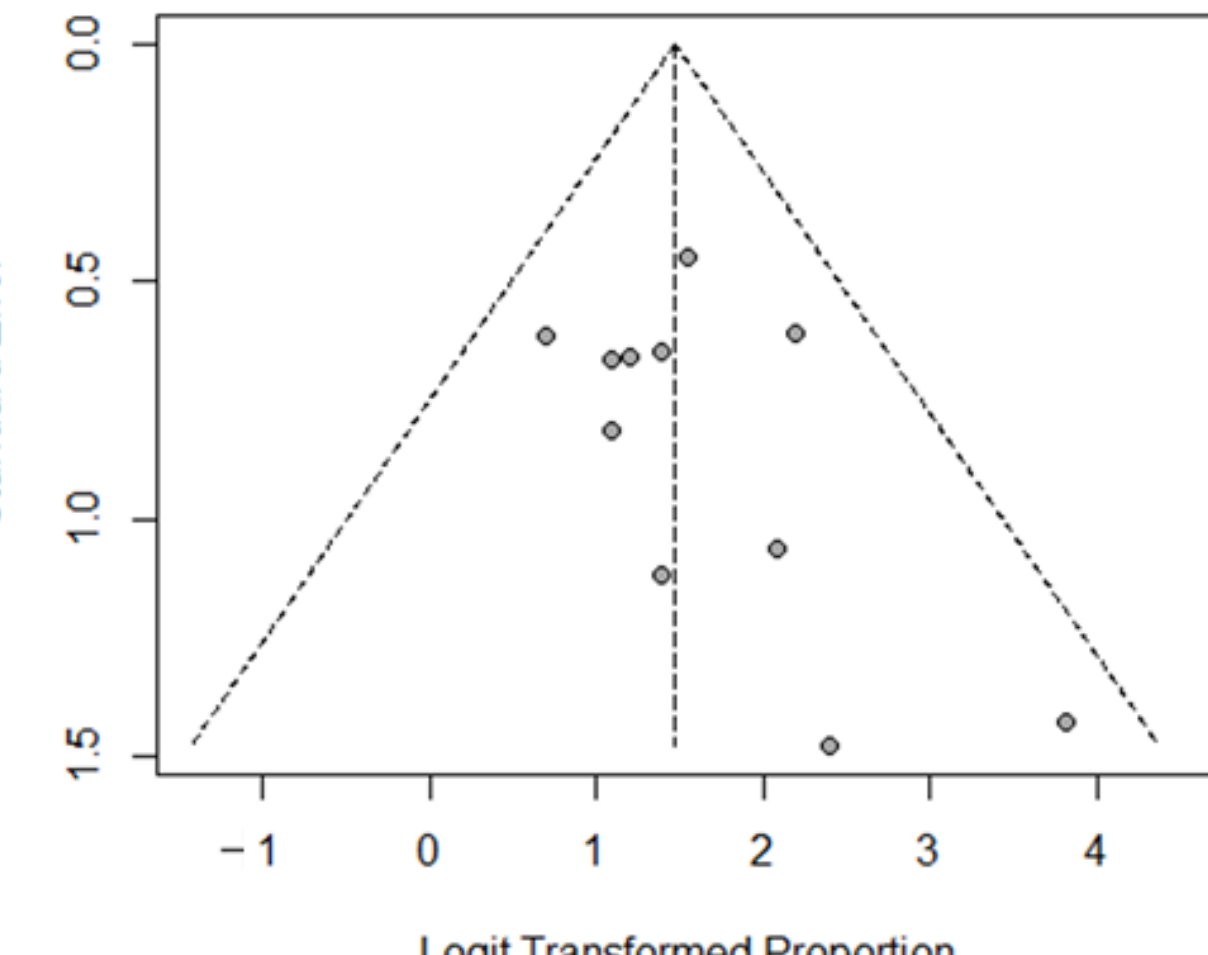
Figure 2. Funnel plot for DCR (disease-control rate) in the selected articles. A forest plot of the treatments’ effect on DCR is shown in Figure 3. There was no statistically significant heterogeneity among the 177Lu- and 90Y- PRRTs studies (I 2 value = 0%, p = 0.68 and I 2 value = 0%, p = 0.91, respectively). The pooled DCRs were 0.83 (95% CI: 0.75–0.88) and 0.76 (95% CI: 0.56–0.89) for 177Lu- and 90Y-PRRT treatments, respec- tively. The pooled DCR for PRRT agents was 0.81 (95% CI: 0.74–0.87). Although the pre- sent study is the largest description of DCR in PRRT therapy of PCCs and PGLs, given the small sample size, no formal attempts were made to compare efficacy between 177Lu- and 90Y-PRRT treatments. Funnel and forest plots for response rate (complete plus partial responses) in the se- lected studies are reported in Figures S1 and S2, respectively. Table S1 synthetized pa- tients’ age and time-to-event outcomes in the analyzed articles.